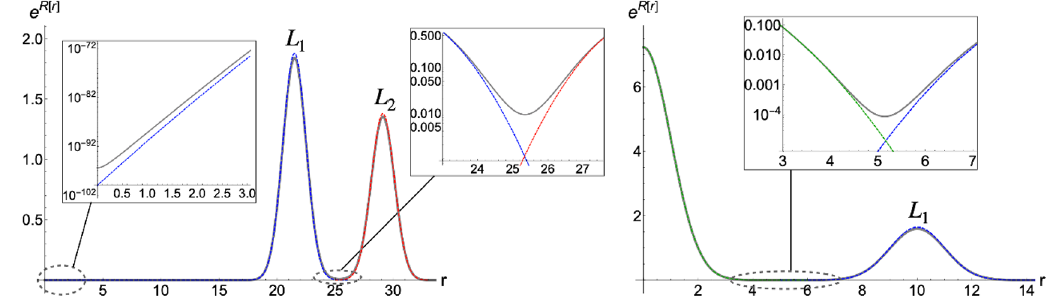
Figure 8 . The radial profile of ripples for N = 4 with Ω = 0 . 04 (left) and N = 3 with Ω = 0 . 1 (right). The blue and red curves are the Gaussian solution R ( r ) = 1 − 1 the fitted peak positions L i . The green curve is the Myers-Perry